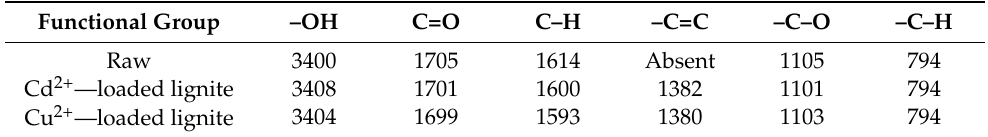
Figure 10. FTIR analysis of lignite before and after Cu (II) and Cd (II) adsorption. Table 4. Peak location for each functional group detected in FTIR spectra for raw and metal-loaded